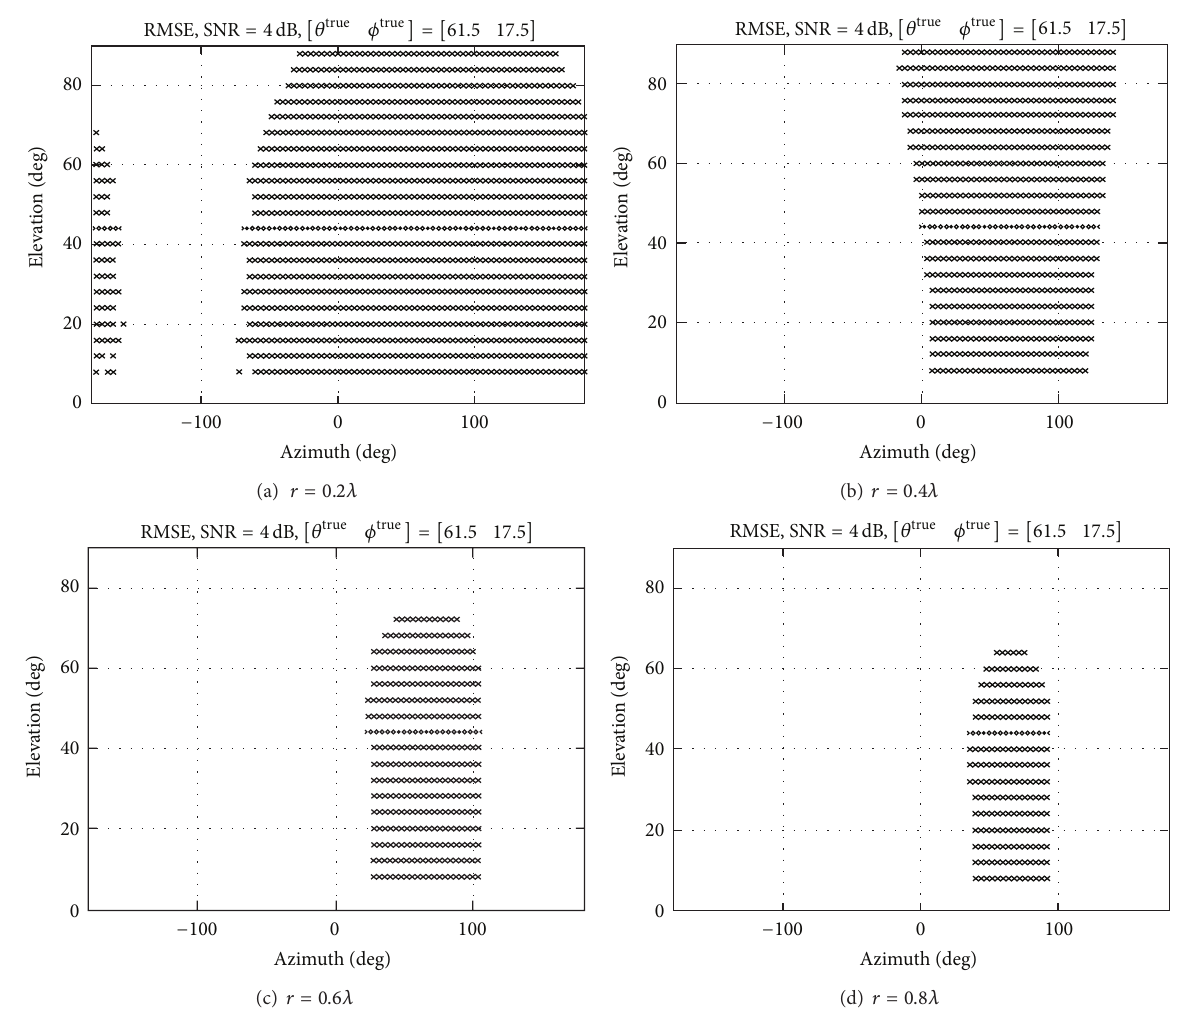
Figure 2: Initial azimuth angles and the initial elevation angles resulting in the global convergence for various radii at SNR =